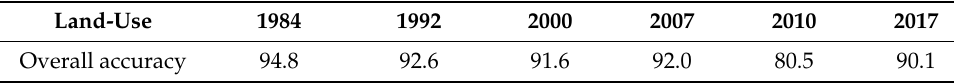
Table 3. Validation statistics of each land-use